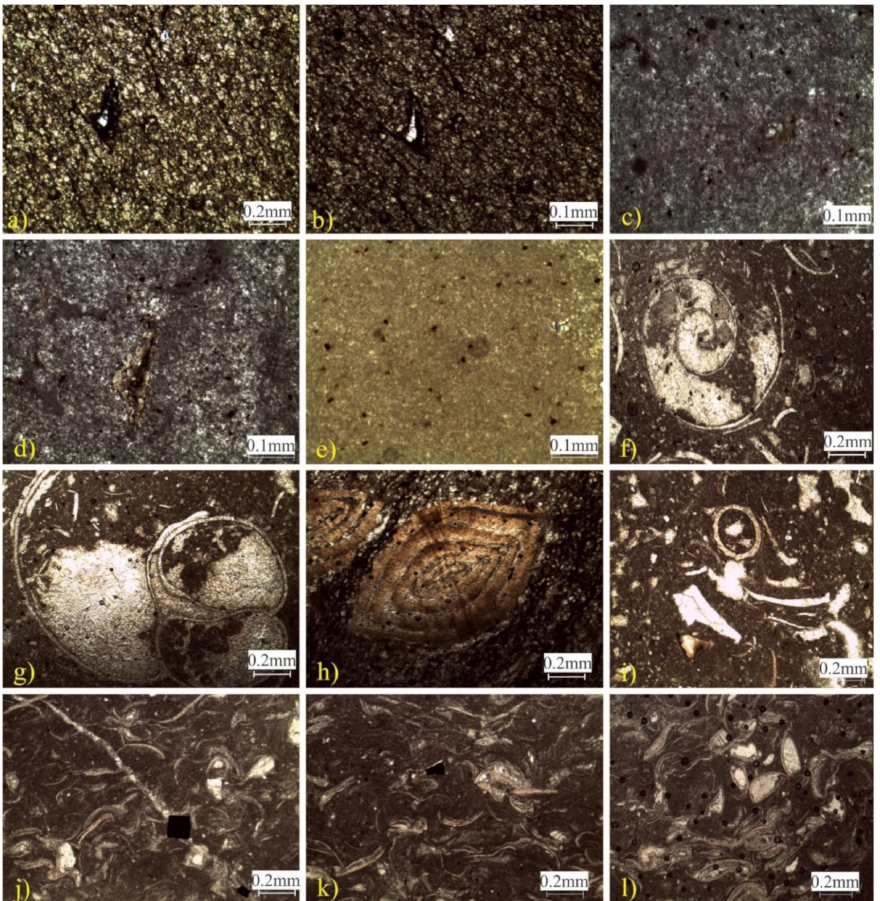
Figure 11. Photomicrographs of the limestone of the study area: ( a , b ) Micritic mudstone with miliolids, ( c , d ) Chalcedony in micritic mudstone, ( e ) micritic mudstone, ( f , g ) Gastropods filled with spar, ( h ) Nummulites spp. in wackstone, ( i ) and bioclast ( j – l ) Ostracods filled with spar, Pyrite and Calcite